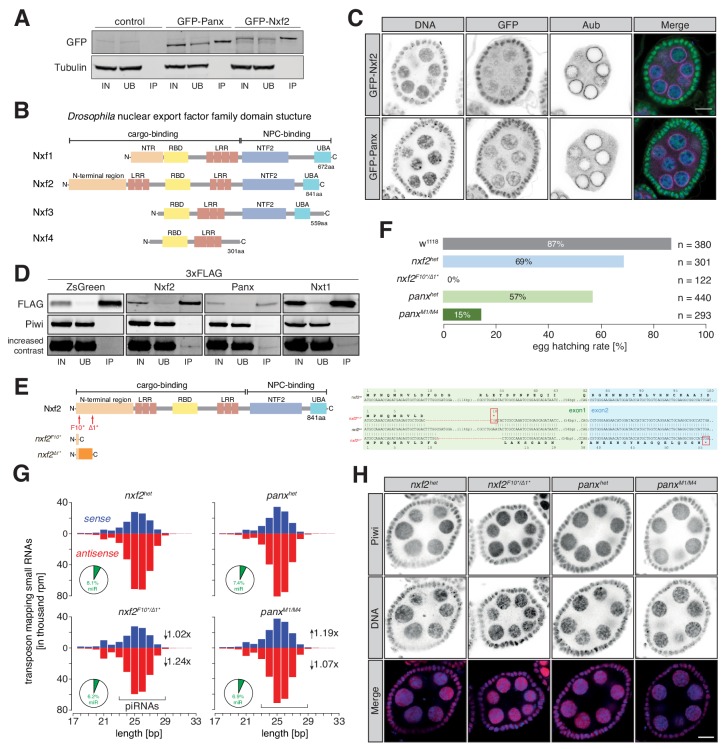
Nxf2 is a piRNA pathway factor acting in TGS.(A) Western blot analyses of GFP-trap co-immunoprecipitation from lysates of ovaries from the indicated genotypes (representative replicate subjected to mass spectrometry analysis; IN, input; UB, unbound; IP, immunoprecipitate). (B) Cartoon displaying the domain structure of the Drosophila nuclear export factor (NXF) family. NTR, amino-terminal region; LRR, leucine rich repeats; RBD, RNA-binding domain; NTF2, NTF2-like domain; UBA, Ubiquitin associated domain. (C) Expression and localization of GFP-Nxf2 and GFP-Panx alongside Aubergine (Aub) and DNA (visualized by DAPI) in an egg chamber is shown by immunofluorescence. Scale bar, 10 µm. (D) Western blot analyses of FLAG-tag co-immunoprecipitation from lysates of OSCs transfected with the indicated expression constructs (IN, input; UB, unbound; IP, immunoprecipitate). The bottom panel shows Piwi signal with enhanced contrast. (E) Cartoon displaying the domain structure of wild-type Nxf2 and the generated mutants as well as their underlying sequence alterations. (F) Bar graphs showing the egg hatching rate of female flies of the indicated genotypes. (G) Bar graphs showing the size distribution of transposon-mapping small RNAs from ovaries of the indicated genotypes (sense in blue, antisense in red). (H) Expression and localization of Piwi in egg chambers from nxf2 and panx heterozygote and mutant ovaries is shown by immunofluorescence. Scale bar, 10 µm.